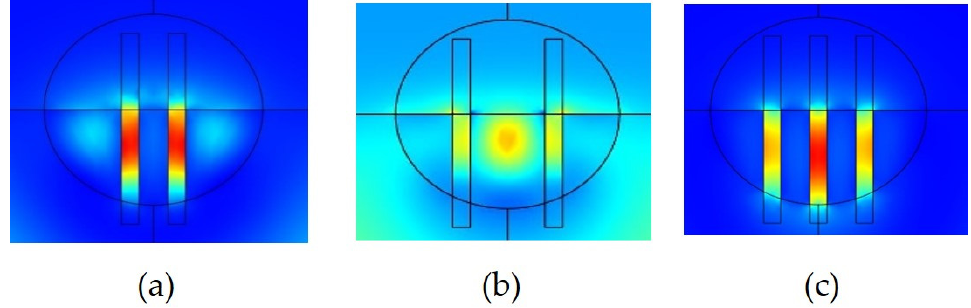
Figure 9. ( a ) Simulation result of one SW in DSCF. The blue curve PCF and orange curve NP vary with slot widths. ( b ) PCF of the two (yellow curve) and three (blue curve) SW in DSCF with varying separation distance.